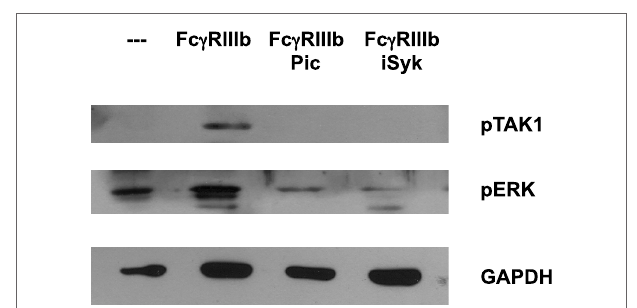
FigUre 5 | syk is required for Fc γ riiib-mediated TaK1 activation . Human neutrophils were left untreated (---), or were stimulated by cross- linking Fc γ RIIIb for 15 min in the absence or presence of 50 μ M Piceatannol (Pic) or 40 nM iSyk, both selective inhibitors of Syk. Cell lysates were prepared after stimulation. Proteins were resolved by SDS-PAGE and then Western blotted for phosphorylated-TAK1 (pTAK1) (upper panel), or for phosphorylated ERK (pERK) (middle panel), and for total glyceraldehyde 3-phosphate dehydrogenase (GAPDH) (lower panel). Data are representative of three separate experiments.